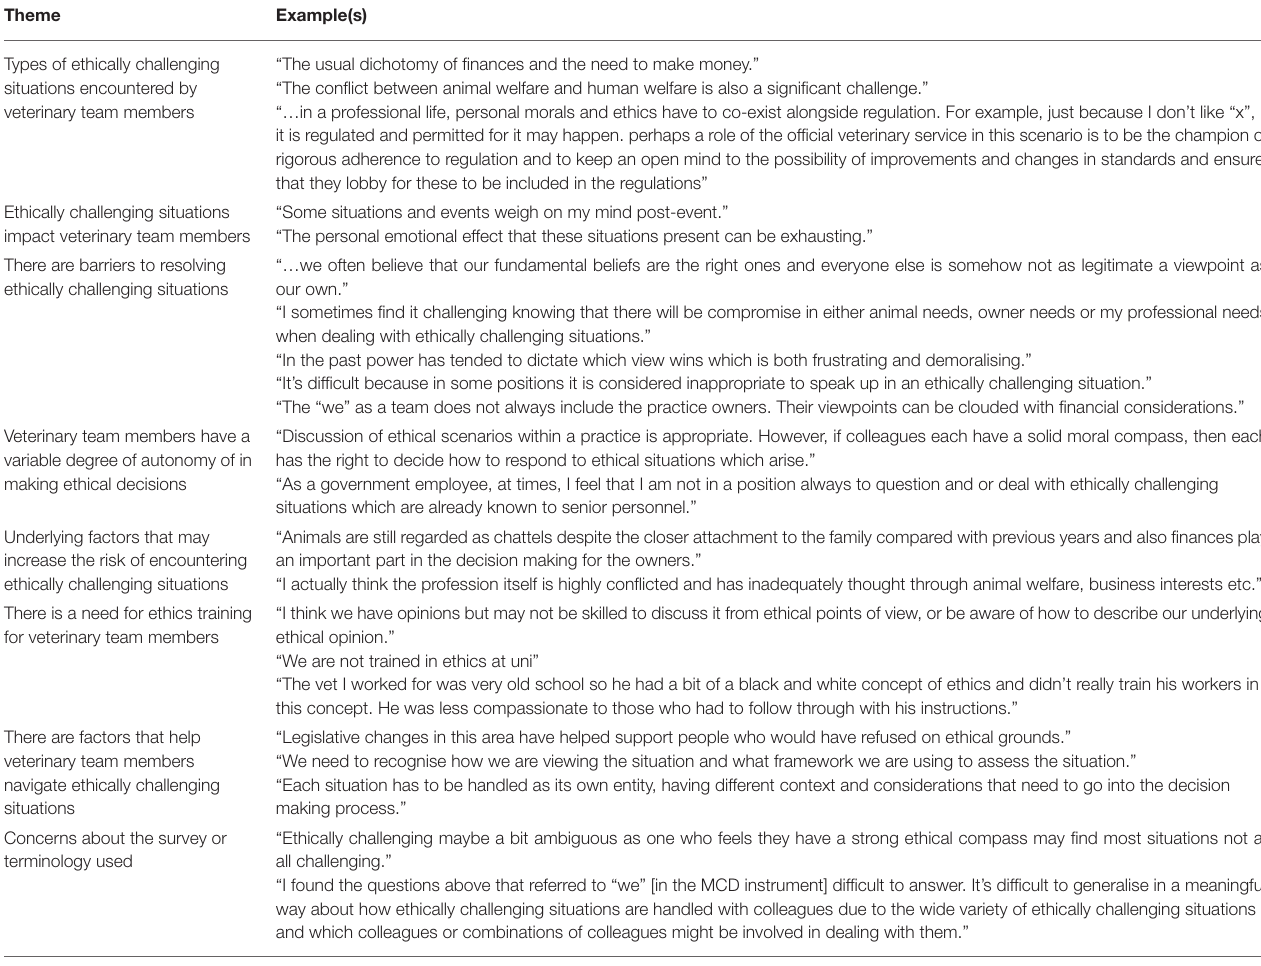
TABLE 7 | Themes constructed through reflexive thematic analysis of free-text responses to the question “Is there anything you wish to add about ethically challenging situations you have encountered in the course of your work?” in a survey of veterinary team members following participation in virtual ethics rounds ( n = 89). Theme Example(s) Types of ethically challenging situations encountered by veterinary team